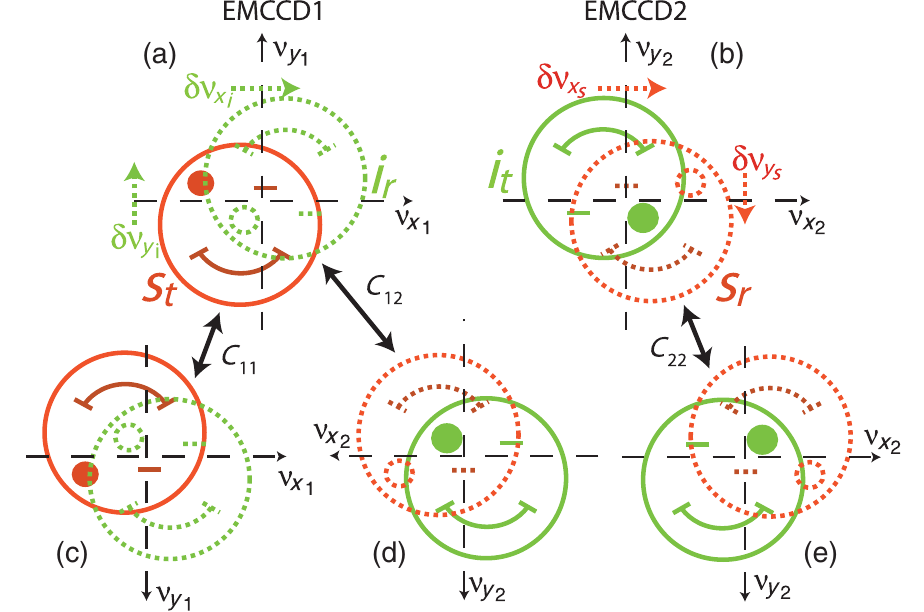
FIG. 2. (a,b) Diagrams illustrating, on both cameras, the relative positions of the far-field patterns of the signal and idler beams, represented in red and green, respectively, when they are either transmitted ( s t , i t ) or reflected ( s r , i r ) as a function of the shifts δν δν δν − δν x i ¼ x s and y i ¼ y s induced by horizontal and vertical tilts of the BS, respectively. The solid and dotted circles correspond to the transmitted beams and to the reflected beams, respectively. The origins of the axes are centered on the barycenters of the images. (c,e) Up-down flip applied to images (a) and (b). (d) Left-right and up-down flips applied to image (b). Spatial correlations can be observed within images symmetrically to the horizontal axes ( C 11 and C 22 ) and between images symmetrically to the image barycenters ( C 12